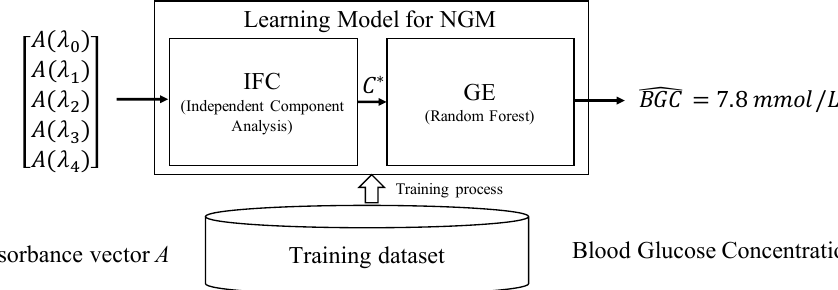
Figure 4. The Schematic Diagram of the Non-invasive Glucose Measurement (NGM) algorithm consisting of the Independent Feature Converter (IFC) and Glucose Estimator